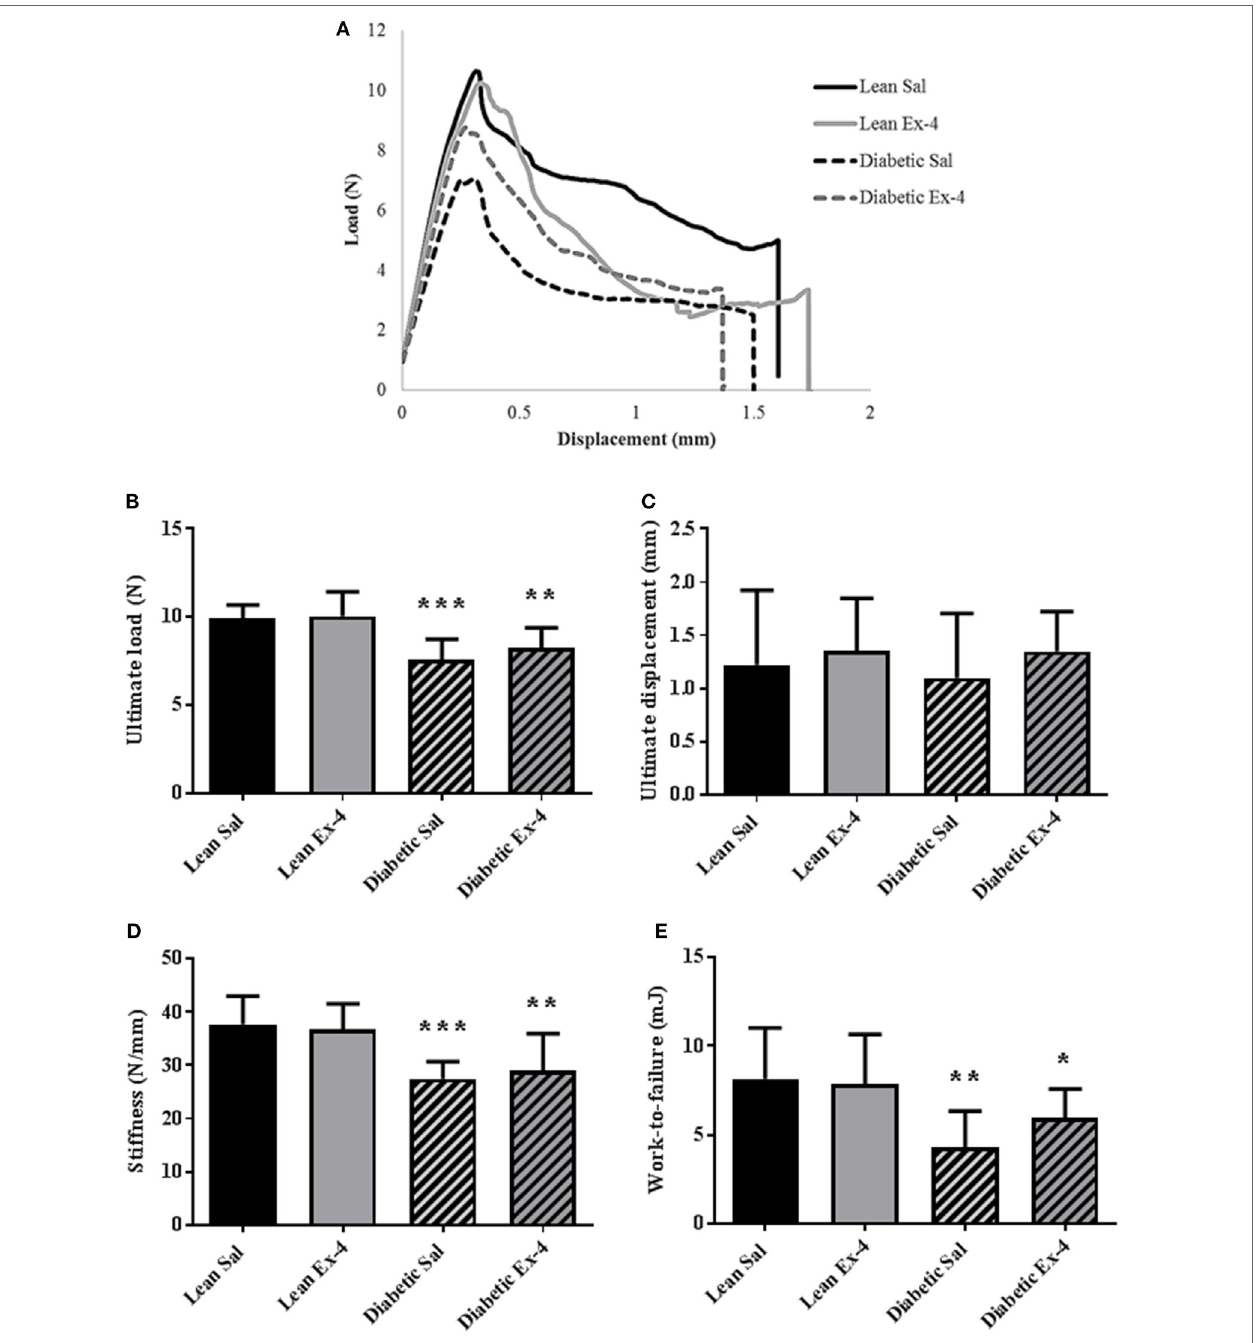
FigUre 5 | Effect of Exenatide on trabecular bone strength in db/db and control mice. Mechanical parameters were recorded in whole left femur using three-point bending in 13-week-old db/db and lean mice treated with either Exenatide (10 μ g/kg/day) or saline. (a) Examples of load-displacement curves. (B) Ultimate load. (c) Ultimate displacement. (D) Stiffness. (e) Work-to-failure. Bars represent mean ± SD of n = 10 mice/group, * P < 0.05, ** P < 0.01, *** P < 0.001 versus lean